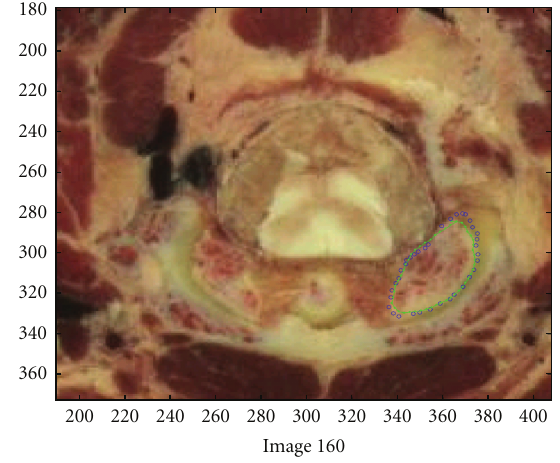
Figure 1: GUI to define contours of the bony structures from the visible human